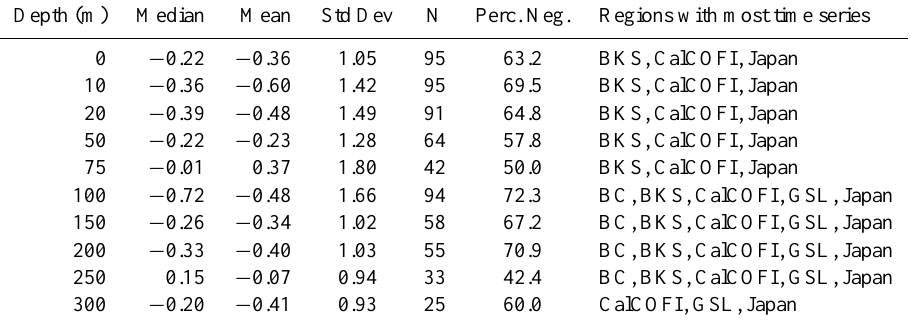
Table 5. Oxygen trend statistics (µmolL − 1 yr − 1 ) calculated from raw data in the coastal ocean, 0–30km from the shoreline, for the 1976– 2000 period. Abbreviations: C. I. = confidence interval; Std Dev = standard deviation; N = number of time series; Perc Neg = Percentage of negative trends. Region abbreviations: BKS = Baltic Sea, Kattegat and Skagerrak; BC = British Columbia; CalCOFI = California Cooperative Oceanic Fisheries Investigations; GSL = Gulf of St. Lawrence.